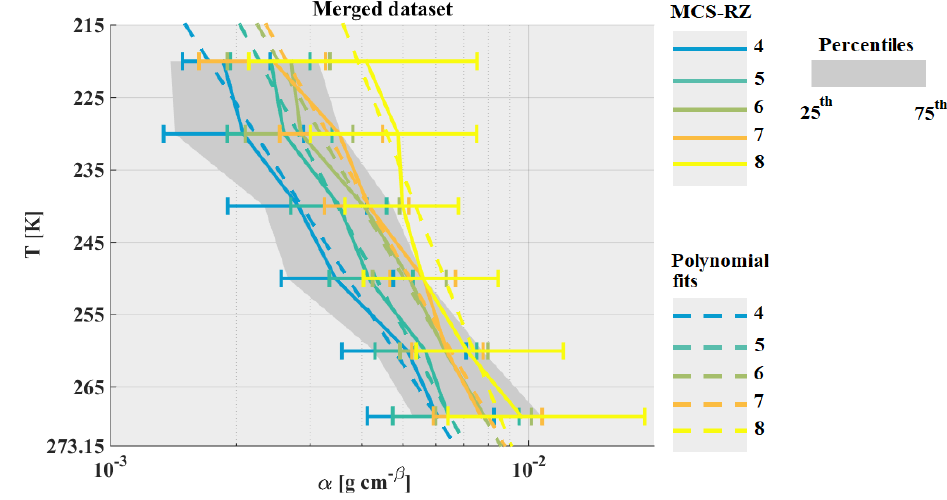
Figure 15. The same as Fig. 5 but for α of mass–size relationships for the used ice hydrometeor size definition D max .